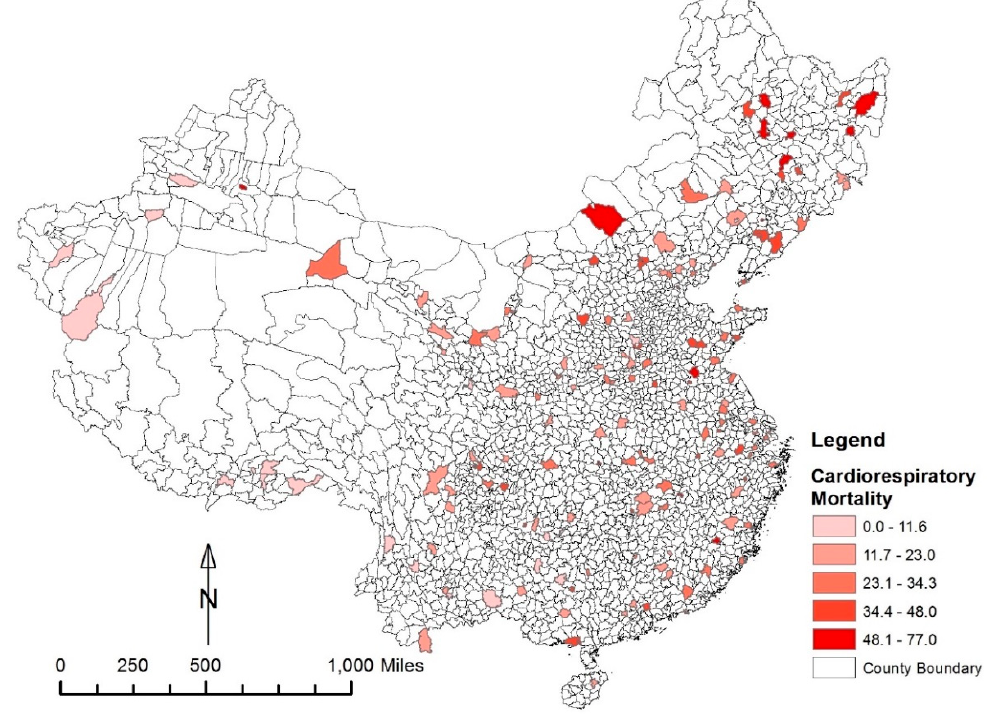
Figure 1. Spatial distribution of cardiorespiratory mortality rate (incidences / 100,000 population) of Disease Surveillance Points (DSP) sample sites in the year 2005.